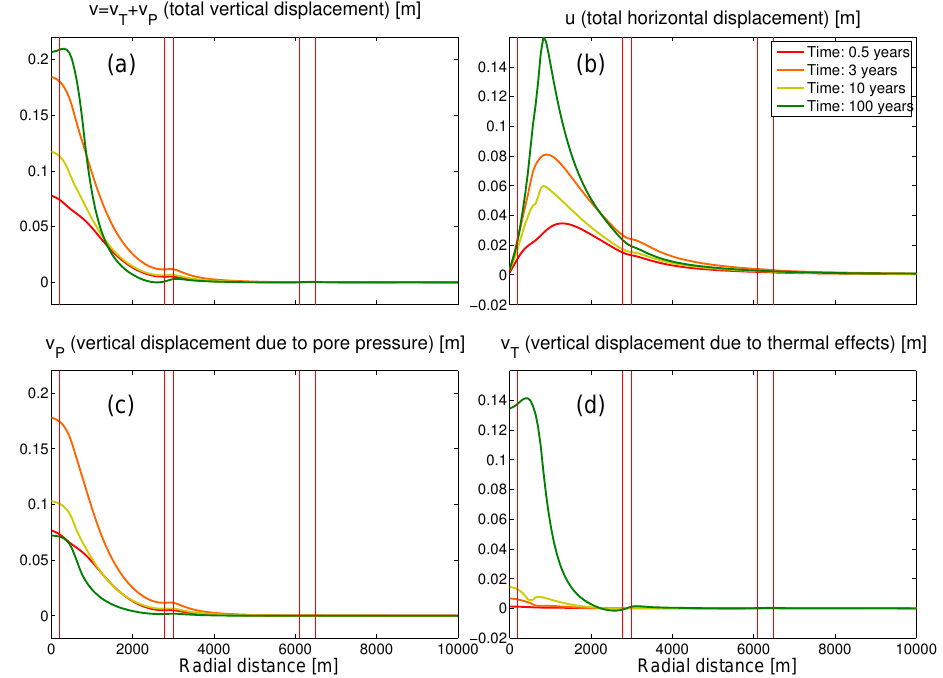
Figure 7. Ground deformation computed for Scenario I at the surface after t = 0 . 5, 3, 10 and 100 years of unrest: total vertical deforma- tion (a) , total horizontal deformation (b) , vertical deformation due to pore pressure (c) , and vertical deformation due to thermal effects (d) . Vertical lines refer to the boundary of the central conduit and to the injection and shallowest points of faults.